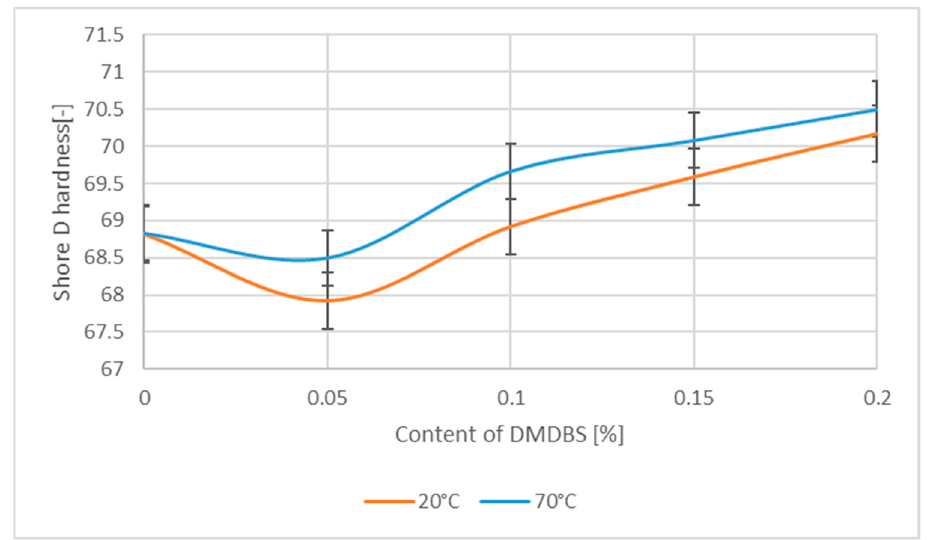
Figure 4. The Shore D hardness as a function of the DMDBS contain in the PP samples.